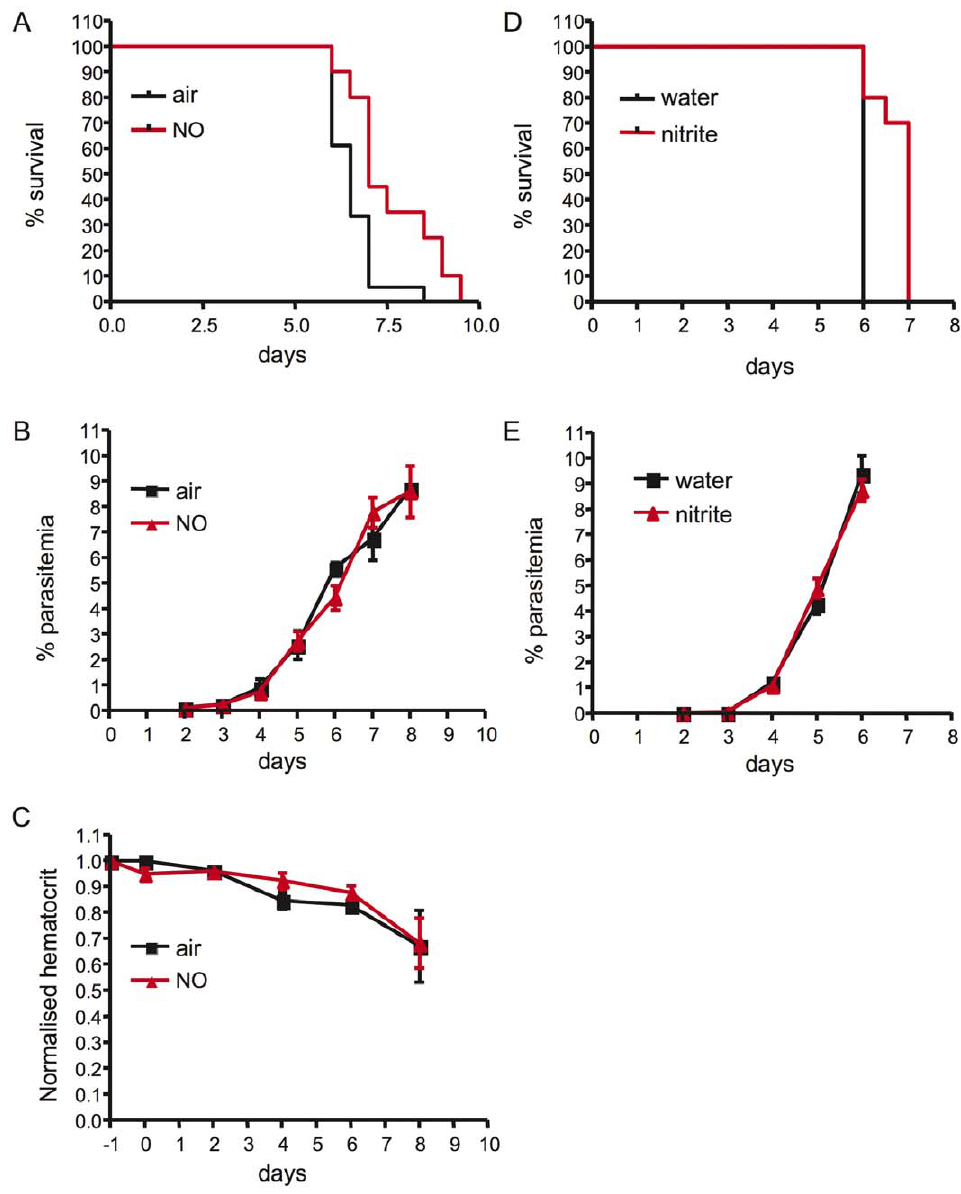
Figure 1. Prophylactic inhaled NO prolongs survival in mice infected with P.berghei ANKA. Kaplan Myer survival curves are shown for C57BL/6 mice infected with 1x10 6 P. berghei ANKA PEs and treated in (A-C) with either 80 ppm NO (red) or air (black) starting one day prior to infection, or in (D-E) with either nitrite (administered in the drinking water at 500 mg/L of water, shown in red) or water (black). Survival (A and D) was assessed twice daily. Significant differences in survival were assessed by Log rank test. For (A) p=0.0007, n=18 in air and n=20 in NO group, representative of 5 independent experiments. For (D) p=0.0004, n=10 per group, representative of 2 independent experiments. Parasitemia levels did not differ between the groups (B and E). Hematocrit did not differ between iNO- and air-treated groups